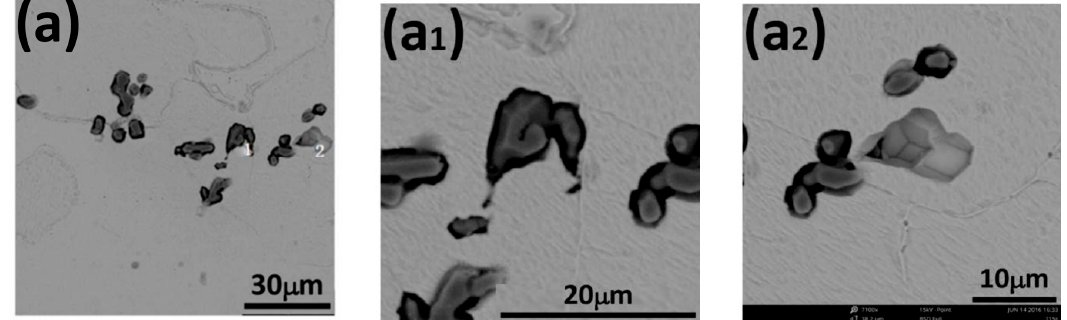
Figure 6. The corroded morphology of clustered Al 2 O 3 at ( a ) 215 s; ( a 1 ) a local enlarged diagram of Position 1; and ( a 2 ) a local enlarged diagram of Position 2.